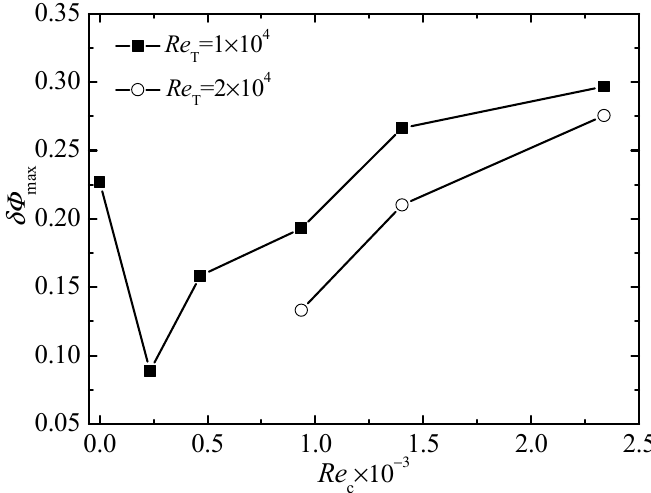
Figure 10. Variations of the maximum fluctuation amplitude of solute concentration with the crucible rotation at Re s = 0.